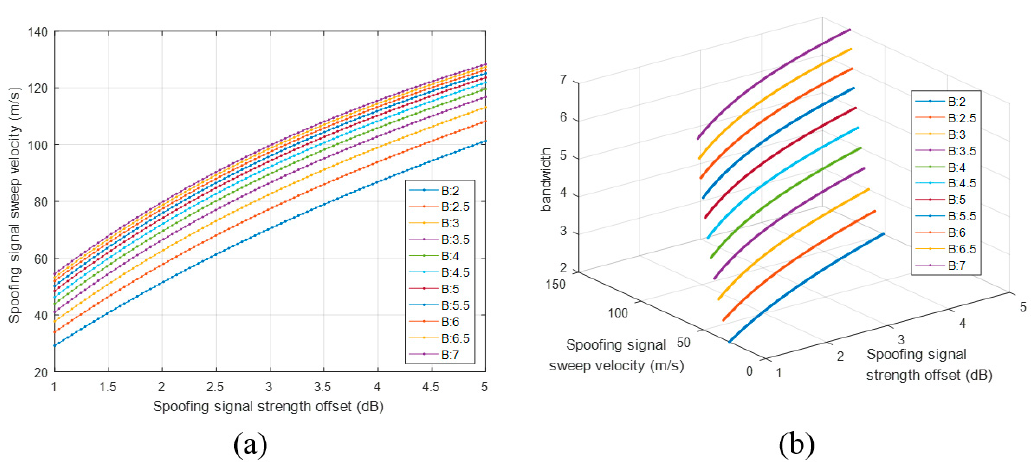
Figure 18. Boundary lines according to the DLL bandwidth ( a ) boundary lines in two dimension; ( b ) boundary lines in three dimension.